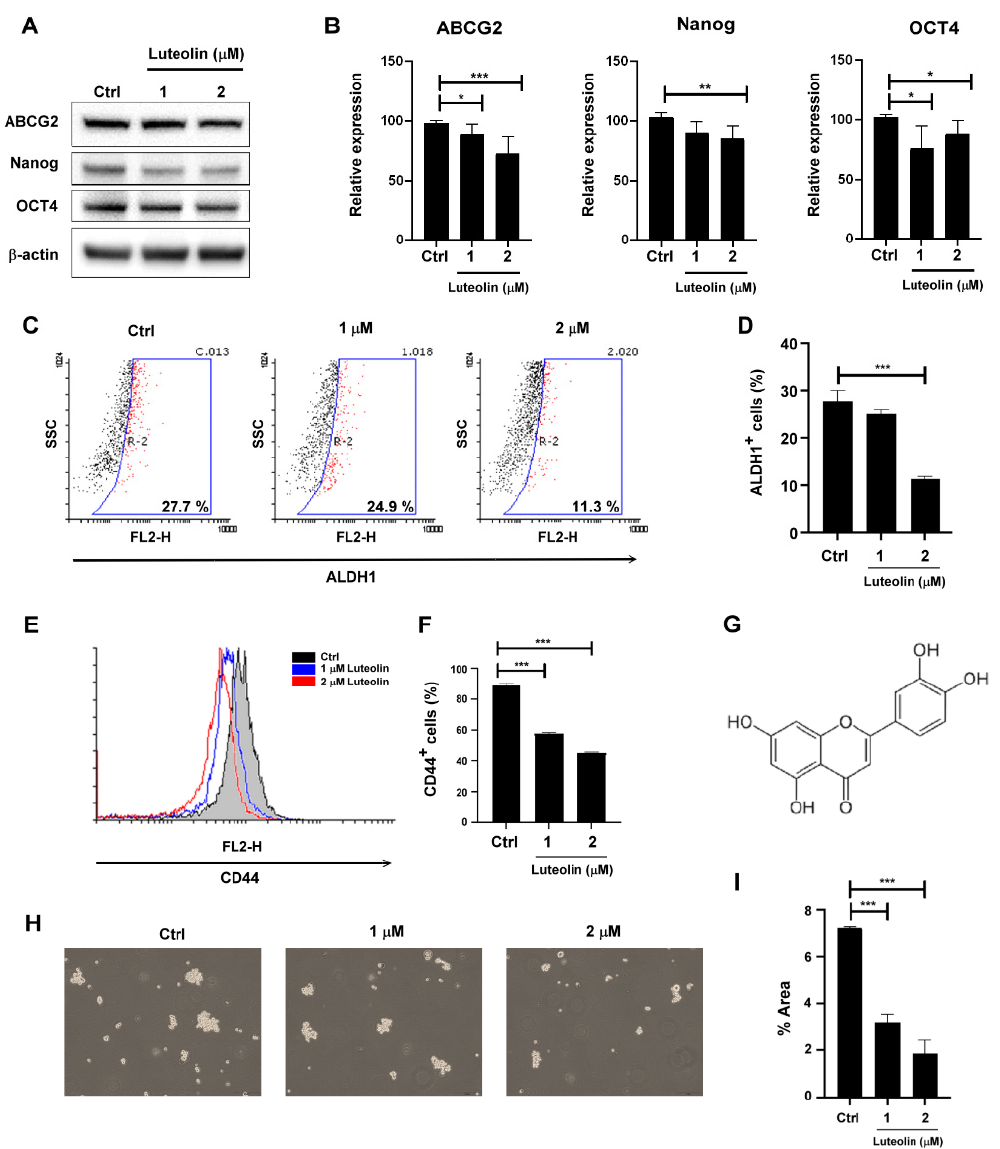
Figure 1. Stemness capacity in MDA-MB-231 cells was reduced by luteolin treatment: ( A ) cancer stem cell (CSC) marker proteins, such as ABCG2, Nanog, and Oct4, were analyzed through Western blotting after 48 h of luteolin treatment; ( B ) quantification of protein expression; ( C ) cells positive for aldehyde dehydrogenase 1 (ALDH1) were analyzed through flow cytometry after 48 h of luteolin treatment; ( D ) quantification of ALDH1 + cells; ( E ) CD44 expression was analyzed by flow cytometry after 48 h of luteolin treatment; ( F ) quantification of CD44 expression; ( G ) structural formula of luteolin; ( H ) images depicting the sphere formation ability following luteolin treatment; ( I ) quantification of the sphere formation area in MDA-MB-231 cells after luteolin treatment. Data are shown as the means ± standard errors of the mean of at least three independent experiments. Two-tailed Student’s t -test: * p < 0.05, ** p < 0.01, *** p < 0.001.